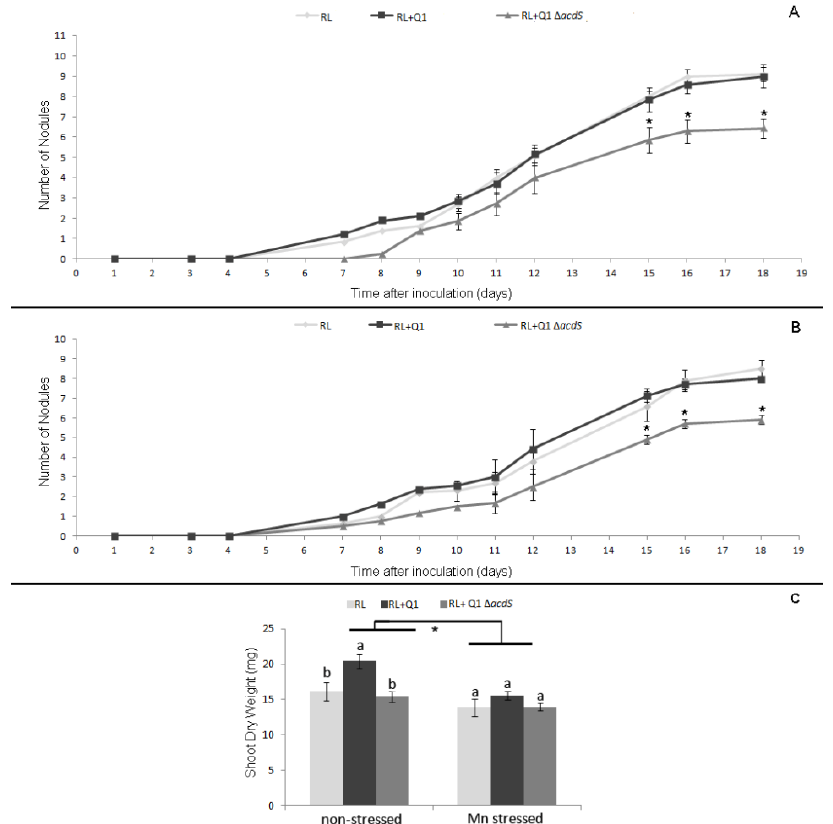
Figure 7. Nodulation kinetics by a hydroponic assay of subterranean clover plants inoculated with R. leguminosarum bv trifolii ATCC14480 T (RL), and co-inoculated with R. leguminosarum bv trifolii ATCC14480 T and Pseudomonas sp . Q1 (RL + Q1) or R. leguminosarum bv trifolii ATCC14480 T and Pseudomonas sp . Q1 Δ acdS (RL + Q1 Δ acdS ). ( A ) Nodulation kinetics of subterranean clover during 18 days under non-stressed conditions. ( B ) Nodulation kinetics of plants during 18 days under Mn